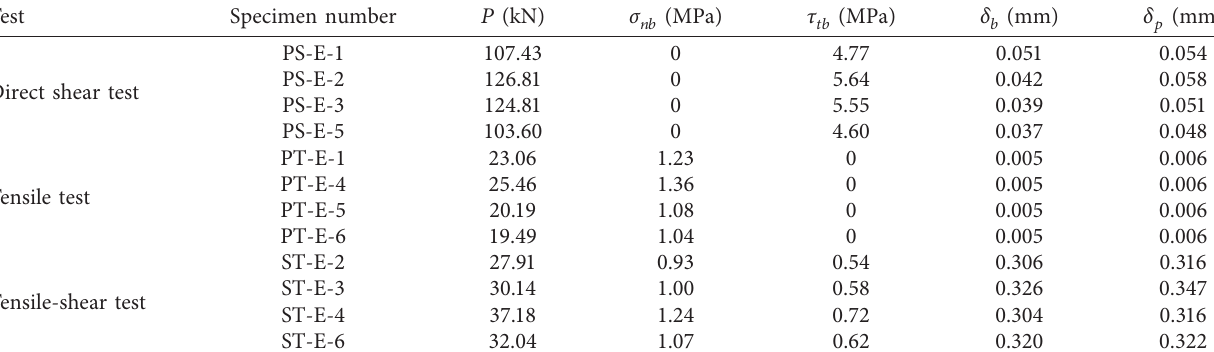
Figure 5: The interface failure of specimen ST-E. (a) Steel plate. (b) UHPC interface. Table 5: Test